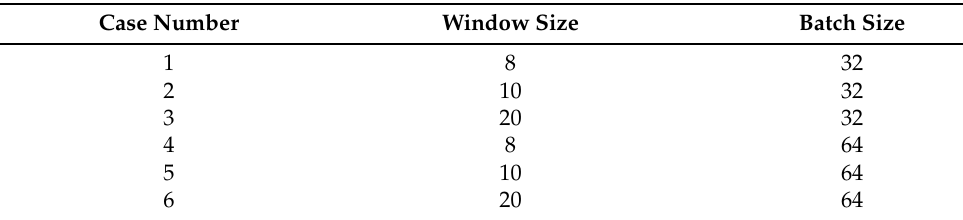
Table 5. Parameters used for each case comparison related to the different cases.